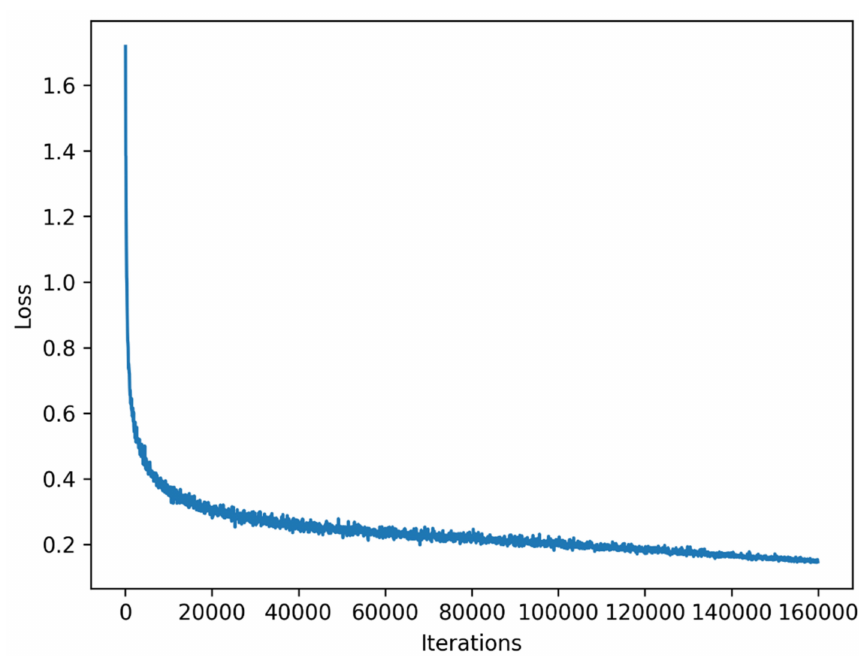
Figure 5. Loss over iterations on Cityscapes